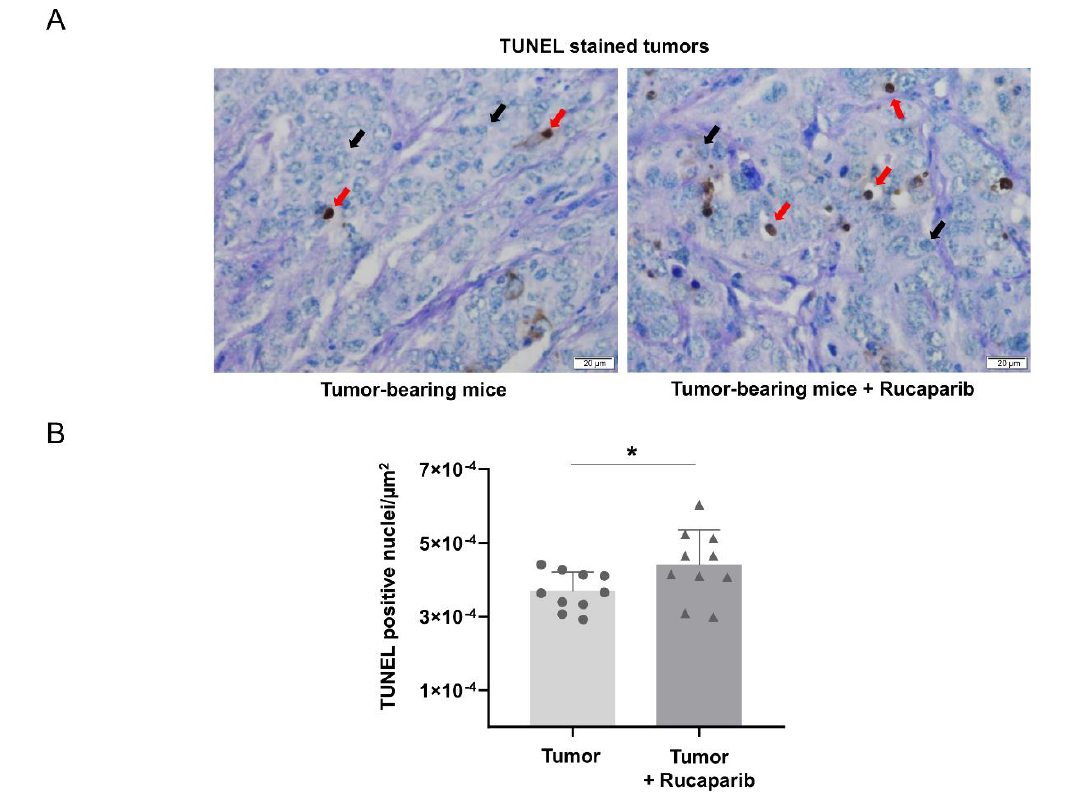
Figure 4. Representative examples of nuclei positively stained for TUNEL (red arrows point towards brown nuclei) and not stained (black arrows point towards blue nuclei, methyl green counterstaining) in the tumors of both experimental groups ( A ). Mean values and standard deviations of positively stained nuclei for TUNEL in the total measured area ( B ). In the scatter plot, the circles represent the untreated tumor-bearing mice while the triangles represent the rucaparib treated tumor-bearing mice. Statistical significance: * p ≤ 0.05 between tumor-bearing mice treated with rucaparib and non-treated tumor-bearing mice. Definition of abbreviations: TUNEL, Terminal deoxynucleotidyl transferase dUTP nick end labelling. Scale bar = 20 μm, 40 × magnification.